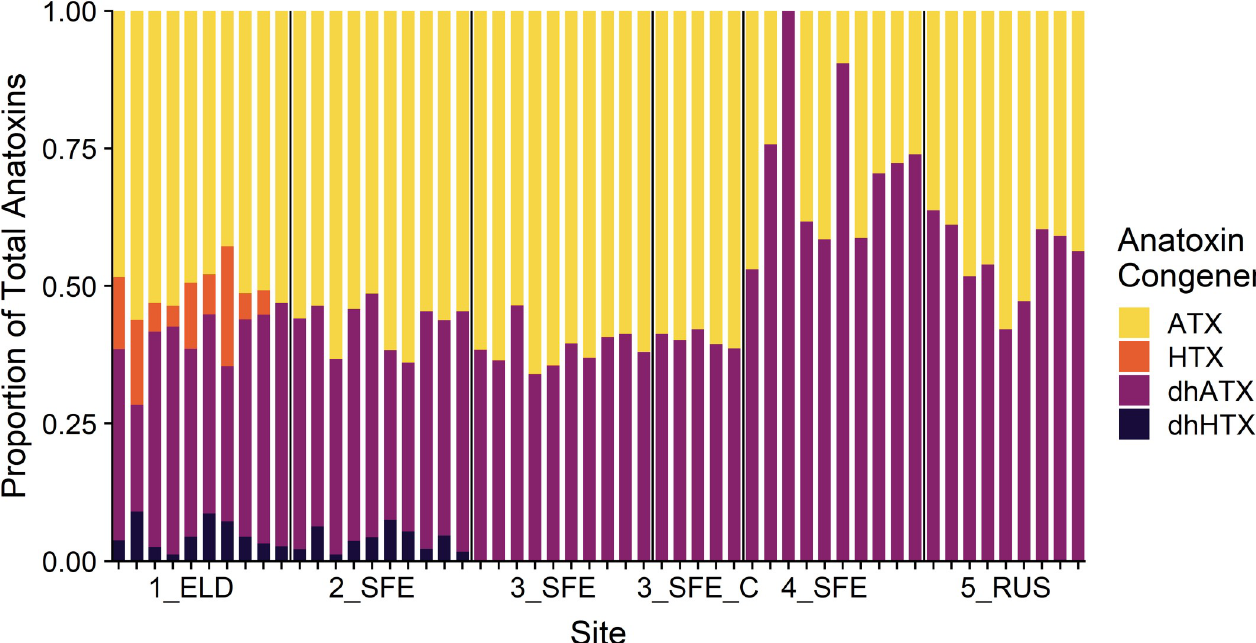
Fig 3. The composition of anatoxin congeners from attached periphyton samples collected at the five sites. Each vertical bar represents one periphyton sample and the vertical black lines delineate each site. 3_SFE_C represents Cladophora -dominated samples at site 3_SFE. ATX = anatoxin-a, HTX = homoanatoxin-a, dhATX = dihydroanatoxin-a, dhHTX = dihydrohomoanatoxin-a.